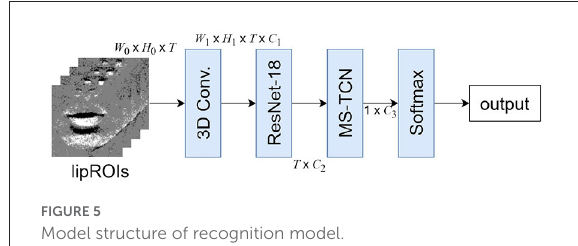
FIGURE5 Model structure of recognition